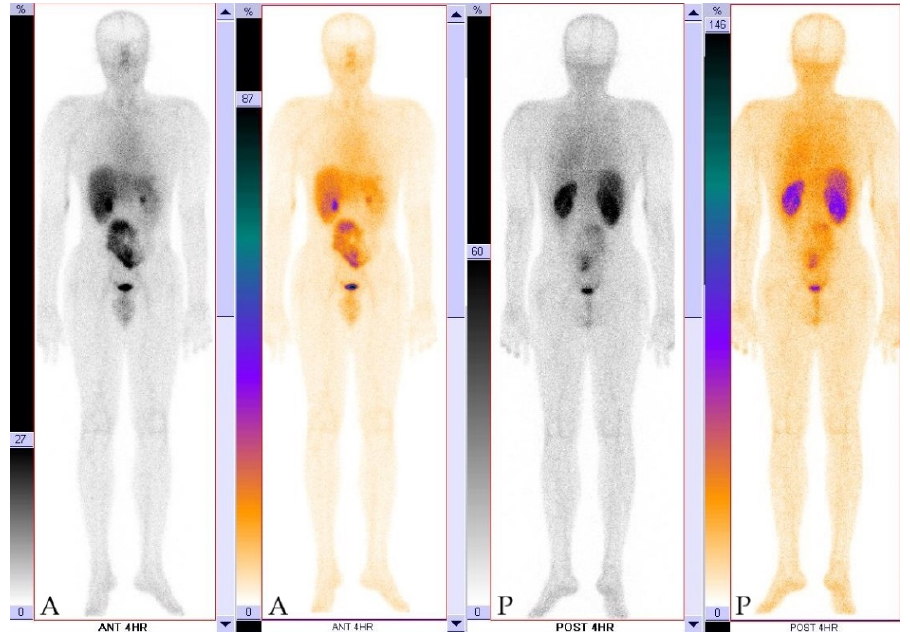
Figure 7. Whole-body [ 99m Tc]Tc-CIP scintigraphy of a healthy patient 4 h (A-anterior and P-posterior) after administration of the radiotracer. Visible physiological radiotracer accumulation mainly in the liver and kidneys.